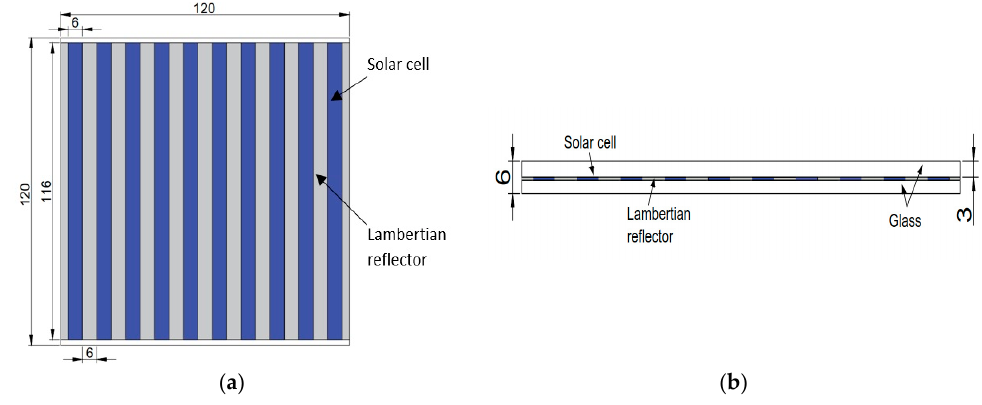
Figure 2. Diagrams of ( a ) the layout; and ( b ) the cross-section of the novel Lambertian reflector-based Concentrating Photovoltaics (CPV) module.